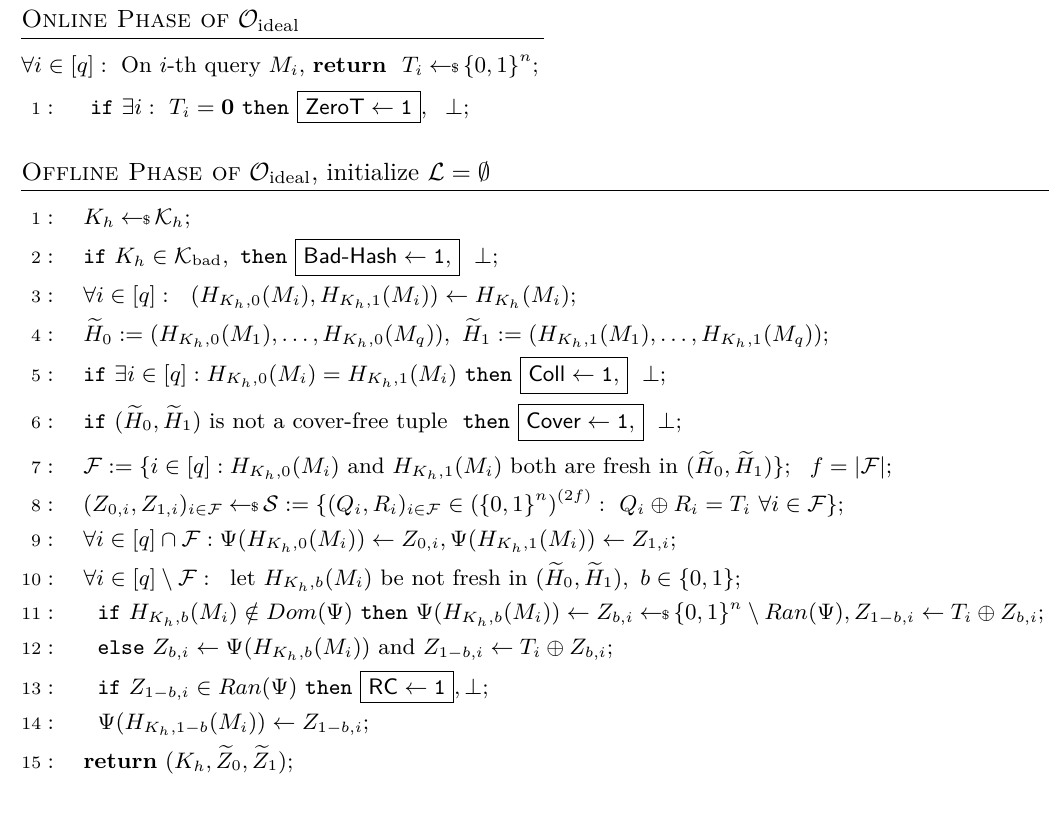
Figure 3.2: Ideal oracle $: Boxed statements denote bad events. Whenever a bad event is set to 1 , the ideal oracle immediately aborts (denoted as ⊥ ) and returns the remaining values of the transcript in any arbitrary manner. So, if the game aborts for some bad event, then we can surely assume that its previous bad events have not happened. Line 10 indicates that there exists some j for which H K and line 11 indicates that permutation output of H K the tuple ( Z 0 , 1 , Z 0 , 2 , . . . , Z 0 ,q ) and e Z 1 denotes the tuple ( Z 1 , 1 , Z 1 , 2 , . . . , Z 1 ,q